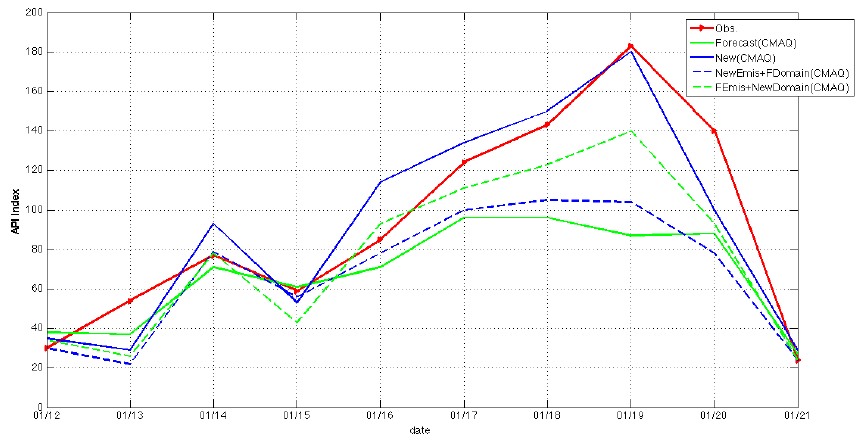
Figure 7. Comparison of measured and modelled daily averaged PM 10 -API of the NSAQ stations in the Beijing urban area. After the improvement in model domain and emissions values, the “New(CMAQ)” results reach to the peak of the observations, which the forecast underestimated.